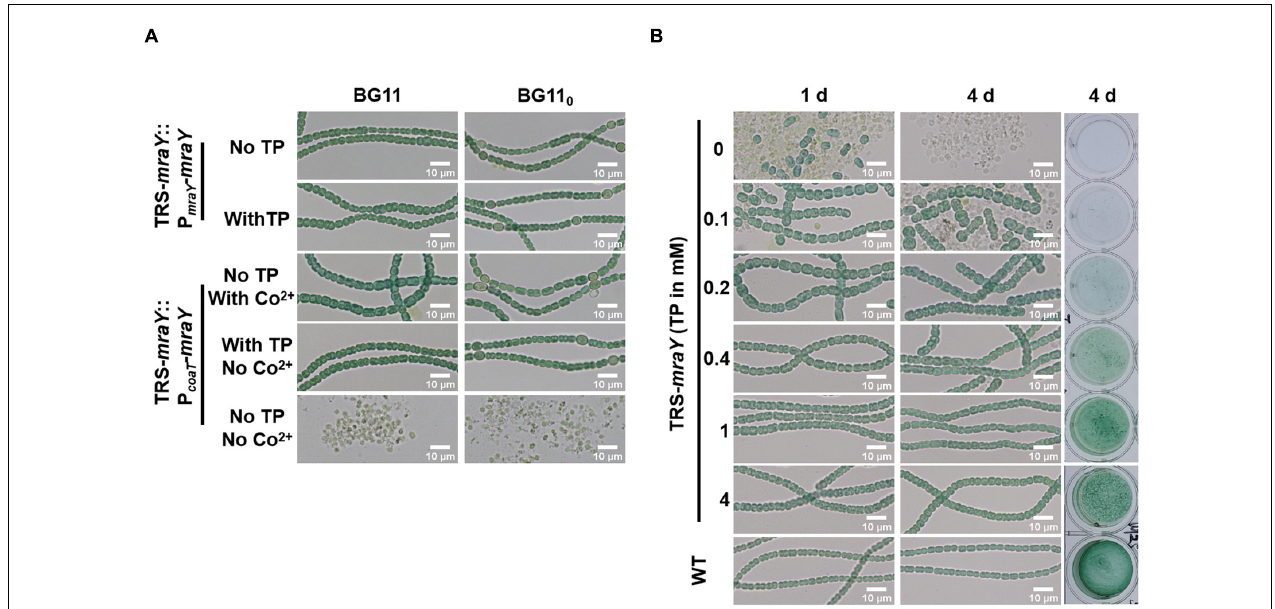
FIGURE 3 | The morphology of cells and filaments. Samples of the cell suspensions from fresh cultures, obtained under different conditions as indicated, were directly observed under a light microscope and photographed. The size in indicated by a bar. (A) TRS- mraY mutant complemented with pP mraY - mraY or pP coaT - mraY grown in liquid BG11 or BG11 0 medium. P mraY is promoter region in front of TSS 1 sequence depicted in Figure 1A . P coaT is a Co 2 + or Zn 2 + inducible promoter cloned from Synechocystis sp. PCC 6803. See text for more details. (B) Filaments of strain TRS- mraY grown in BG11 medium with 1 mM of TP were collected and transferred to BG11 medium without TP for 12 h to deplete residual TP ( Supplementary Figure 5 ). Then filaments were transferred to BG11 medium with different concentrations of TP, incubated for 1, or 4 days, observed by light microscope. The same liquid cultures in vials at 4 days were also photographed (right panel). WT was used as the